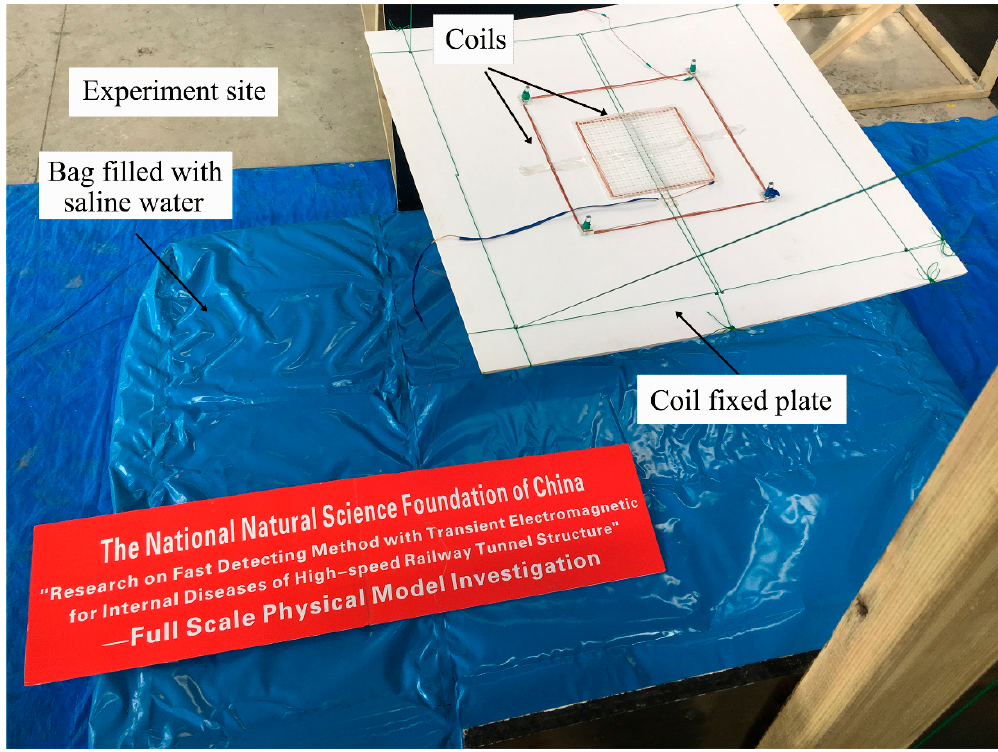
Figure 14. The final layout of laboratory experiment.